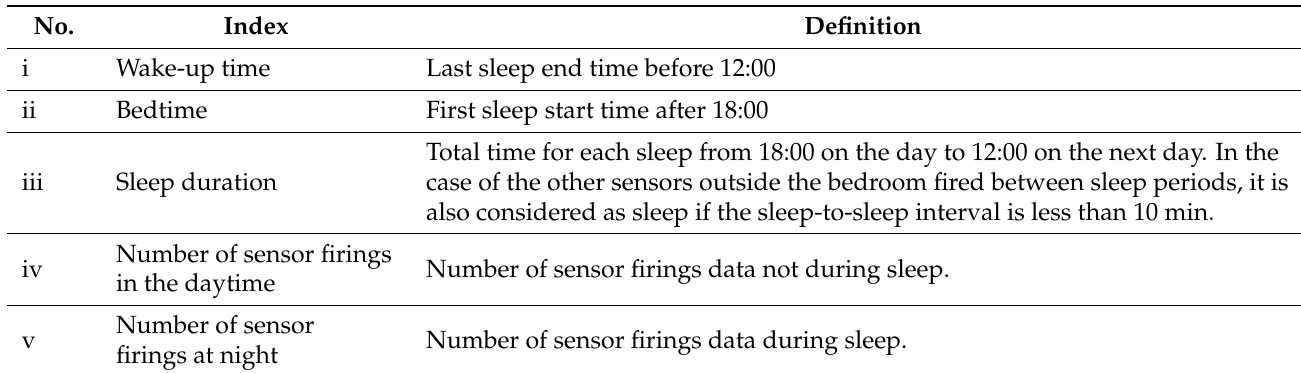
Table 1. Definitions of the indices involving sleep and the indices of the amount of